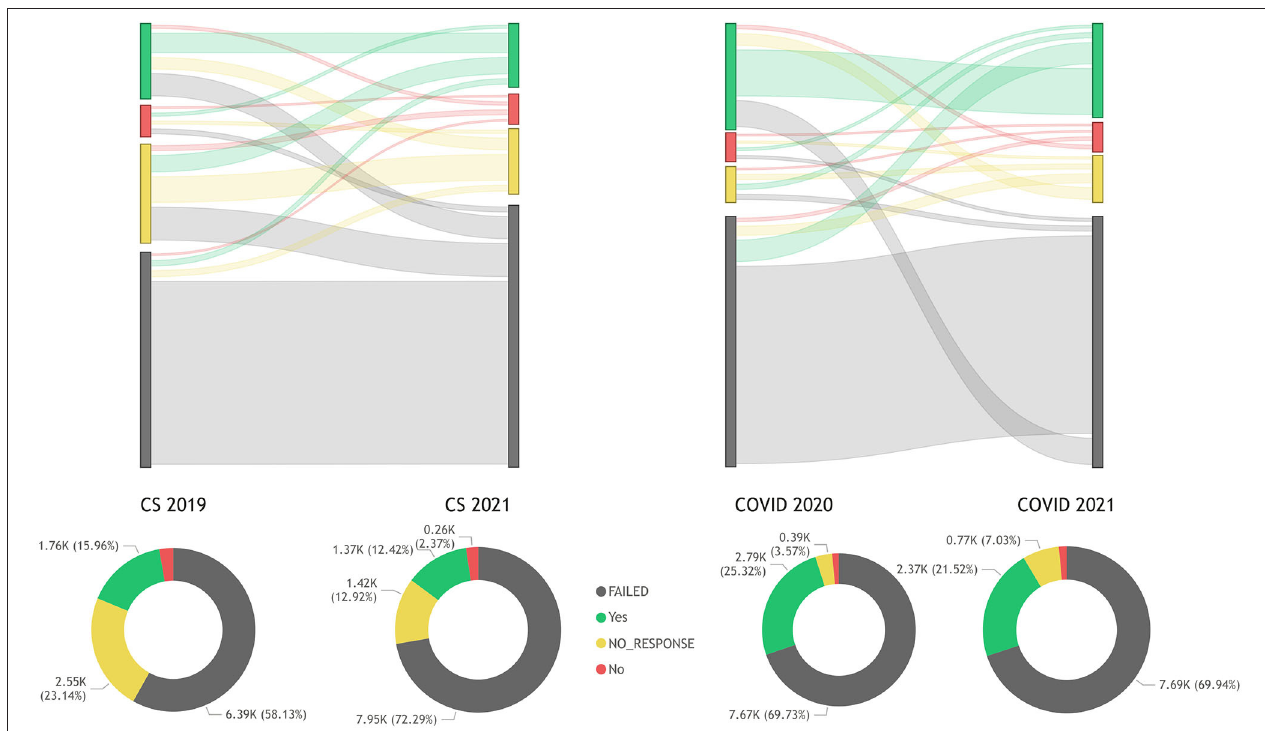
FIGURE 6 | Respondent’s consent (first block of QT) changes between the first and second call round for climate services CS topic (left) and covid-19 COVID topic (right).